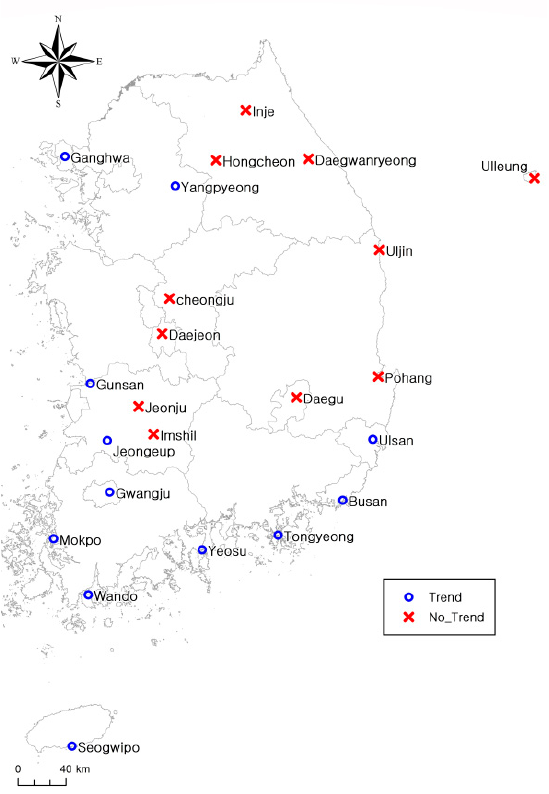
Figure 18. Trend analysis using climate change scenarios.